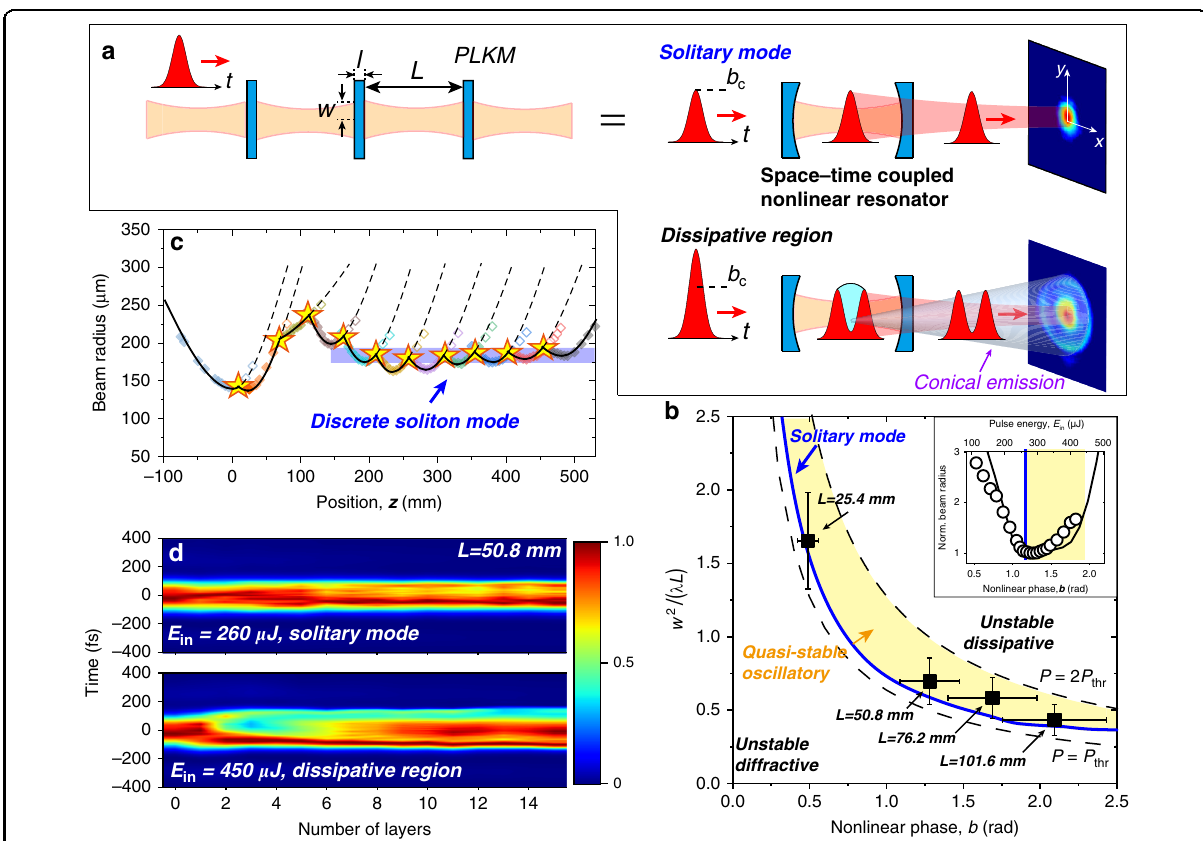
Fig. 1 Formation of spatial solitons in PLKM. a Illustration of the repetitive self-focusing and diverging pattern in PLKM, which is equivalent to a space-time coupled nonlinear optical resonator. The space-time coupled propagation of femtosecond pulses for the solitary modes and in the dissipative region is presented. When the propagation is in the dissipative region, strong conical emission is contributed by the optical energy at the temporal centre of the pulse, leading to temporal pulse splitting. b Universal relationship of the normalized beam radius squared, i.e., w 2 / λ L , as a function of the nonlinear phase b for the resonator solitary modes (solid blue line). The dashed lines represent the boundaries for P thr < P < 2 P thr . The symbols are the experimental results under different resonator lengths. The yellow shaded area is the “ quasi-stable oscillatory region ” . Inset: Variation in the far- fi eld beam radius as a function of the applied nonlinear phase and incident pulse energy for L = 50.8 mm and b c = 1.2. c Experimentally measured beam radii through propagation in the PLKM with L = 50.8 mm and b c = 1.2 under the resonant condition. The beam radius in each layer is indicated by the star symbols. d Evolution of the temporal intensity pro fi les as the pulses propagate through the PLKM under the solitary mode ( E in = 260 μ J) and in the dissipative region ( E in = 450 μ